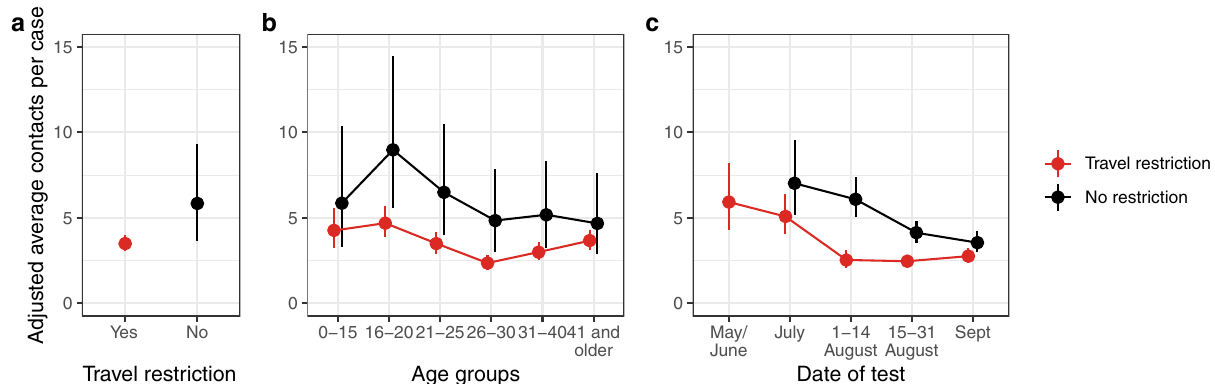
Fig. 3 The effect of travel restriction (14-day quarantine) on contacts per imported case of SARS-CoV-2. The estimated marginal mean number of contacts per imported case a overall, b by age-group and c by date of test comparing countries with travel restriction guidance (closed ‘ travel-corridors ’ ) in place and those without (open ‘ travel-corridors ’ ). All points are estimated marginal means and are provided with 95% con fi